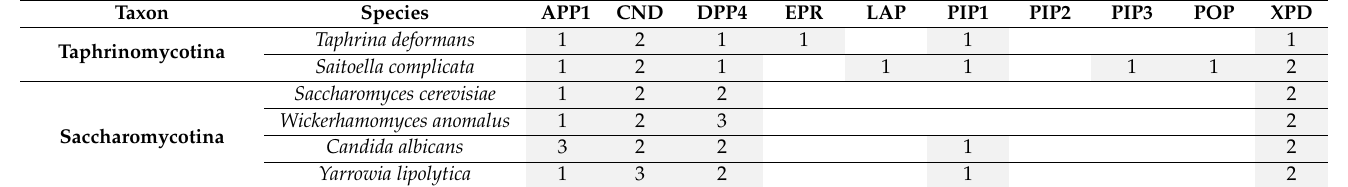
Table 1. Profile of PSP homologs in the genomes of higher fungi. The table cells contain the number of homologs.